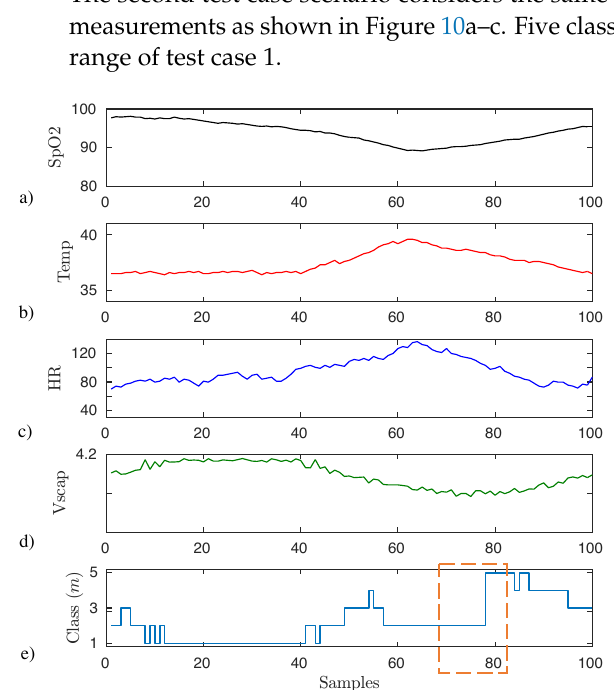
Figure 10. ML-decision tree results for test case scenario 2: ( a – c ) SpO2, Temperature and Heart rate measurements; ( d ) Oscillatory supercapacitor’s voltage; and ( e ) ML-decision tree classification